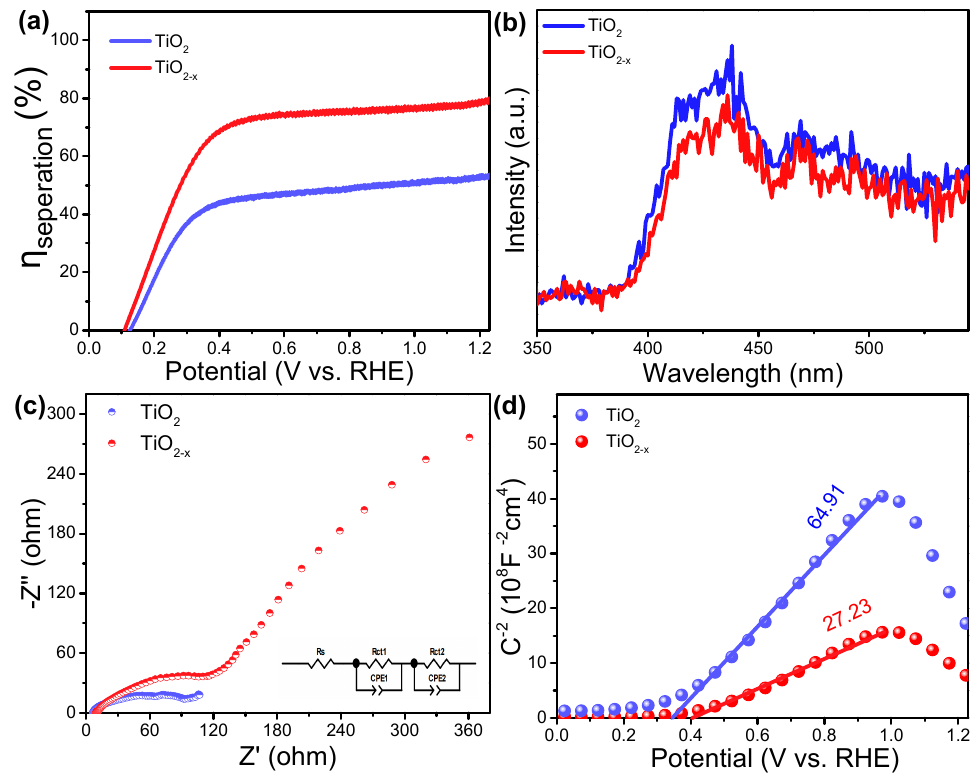
Figure 5. ( a ) Bulk charge separation efficiency; ( b ) PL plots; ( c ) Nyquist plots measured at open circuit; ( d ) M-S plots under dark of TiO 2 and TiO 2-x .